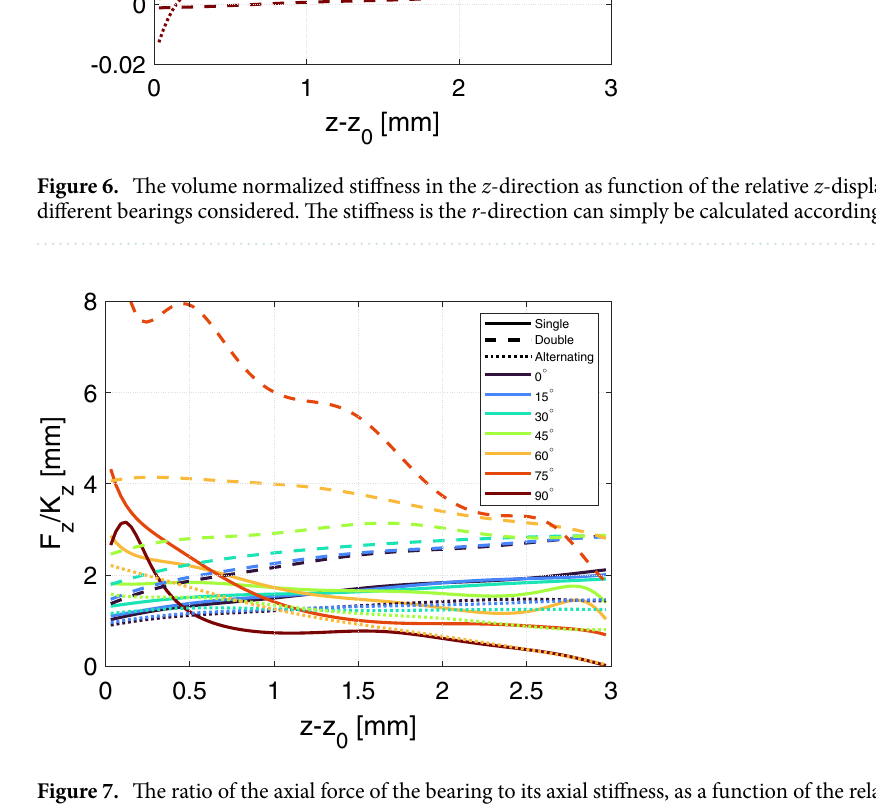
Figure 7. The ratio of the axial force of the bearing to its axial stiffness, as a function of the relative z -displacement for the different bearings